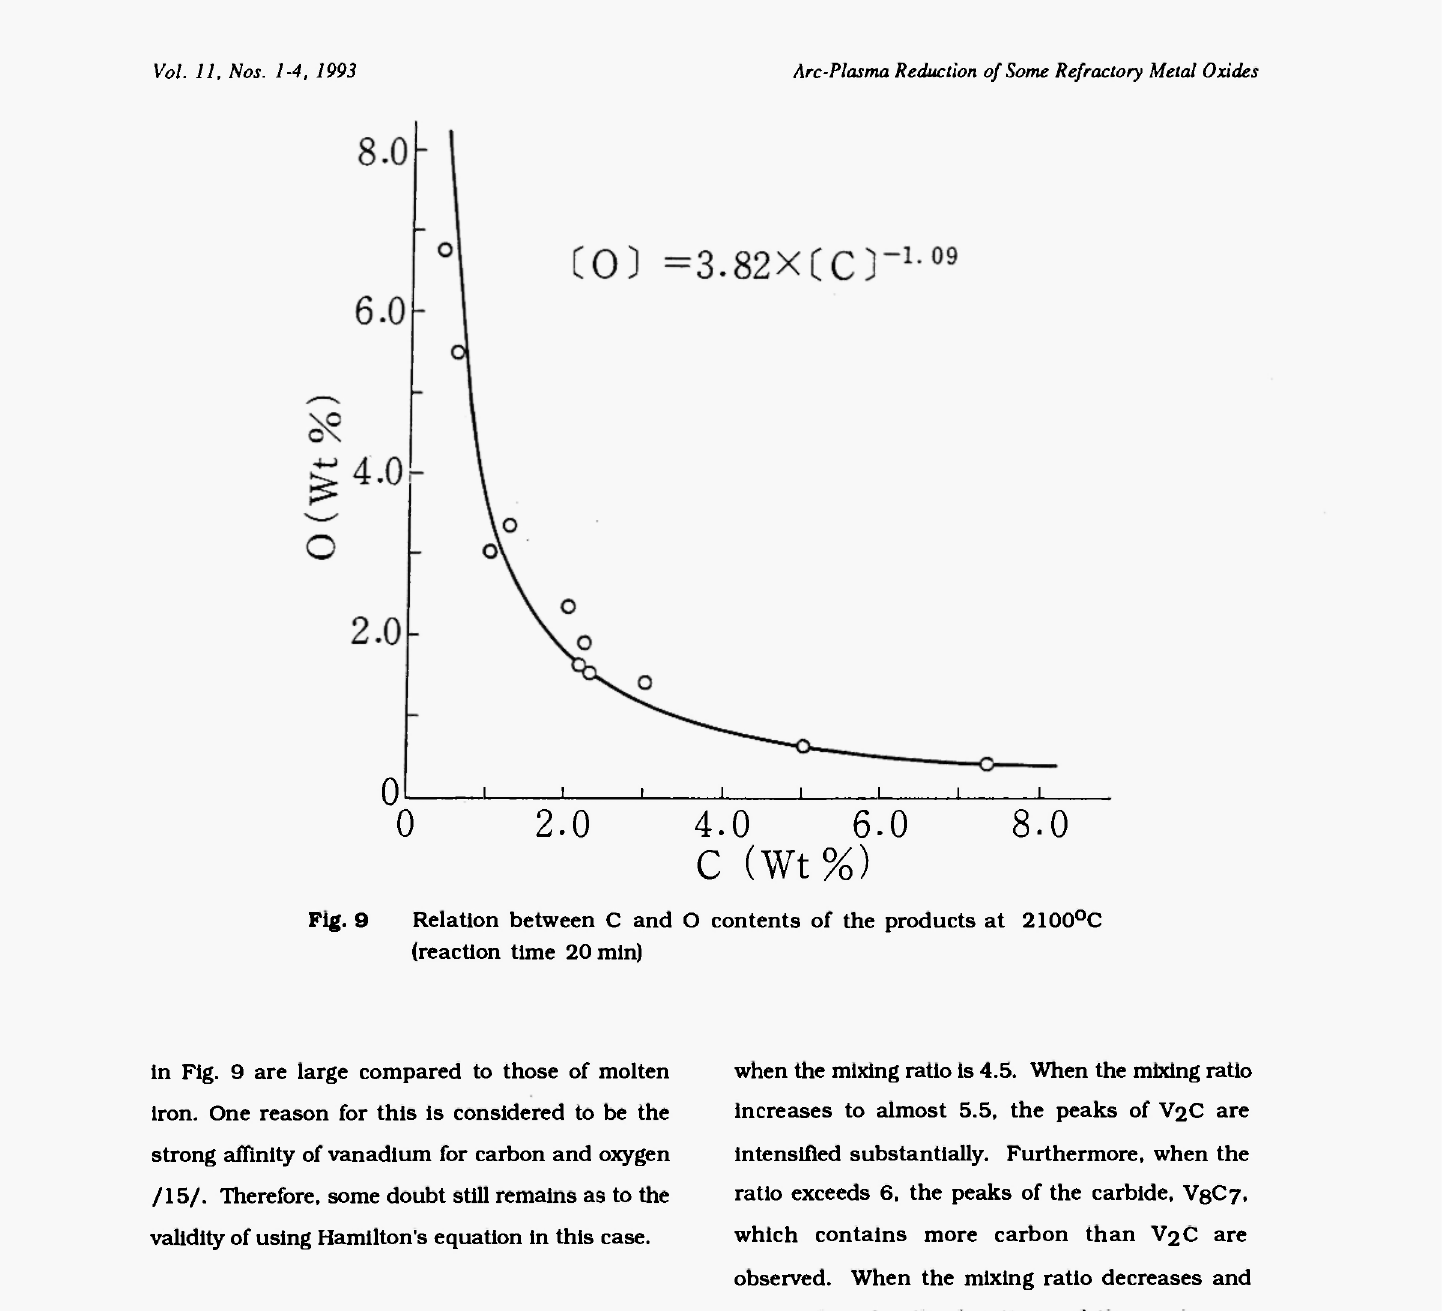
Fig. 9 Relation between C and Ο contents of the products at 2100°C (reaction time 20